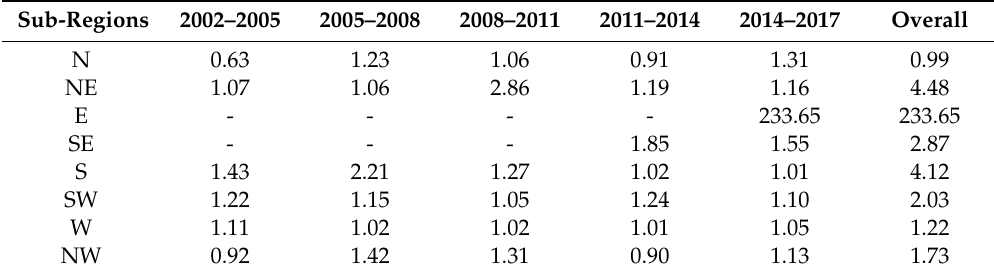
Table 8. Statistics of hot thermal landscape sprawl rate in eight sub-regions from 2002 to 2017. Sub-Regions